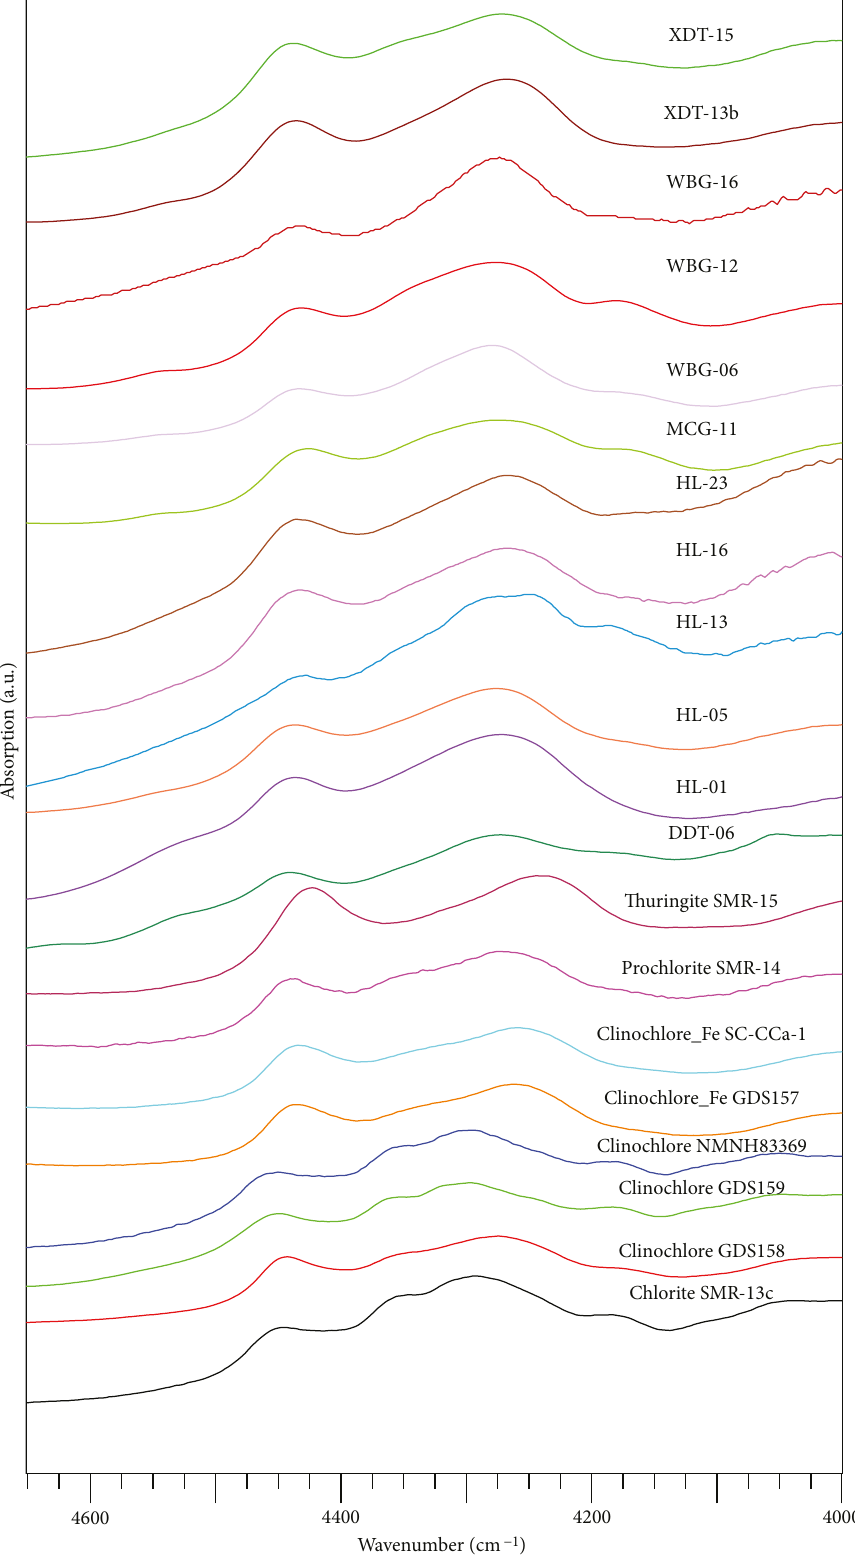
Figure 5: Near-infrared spectra of chlorites in the 4000 to 4878 cm − 1